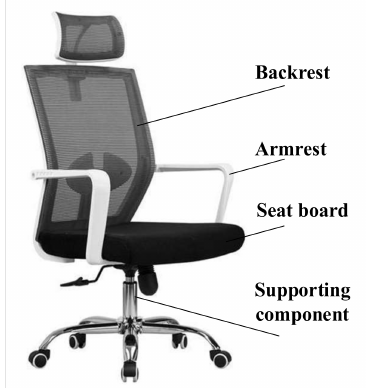
Figure 2. Basic composition of an office